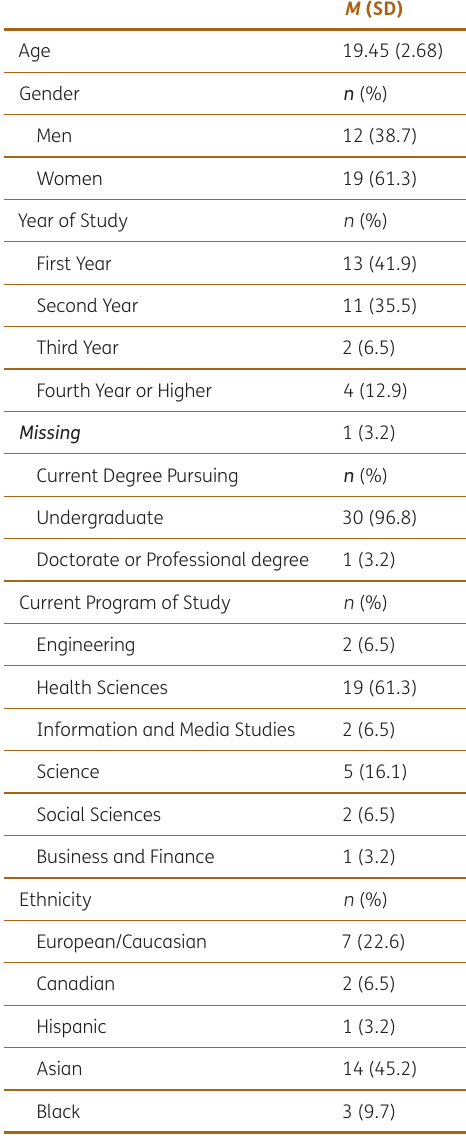
Table 1 Demographic Characteristics ( n =